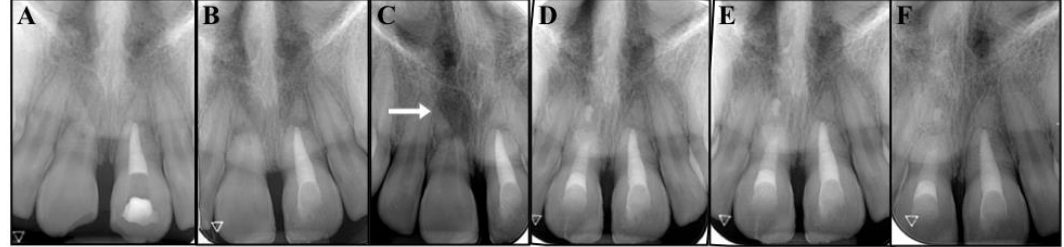
Figure 3. ( A ) Root canal filling with of tooth #2.1. ( B ) Post obturation and restoration of tooth #2.1. ( C ) The 6-month follow-up periapical radiograph reveals the radiolucency of tooth #1.1 (arrow). ( D ) Root canal filling with Portland cement and resin restoration of tooth #1.1. ( E ) Image from the 12-month follow-up. ( F ) Image from the 30-month follow-up.